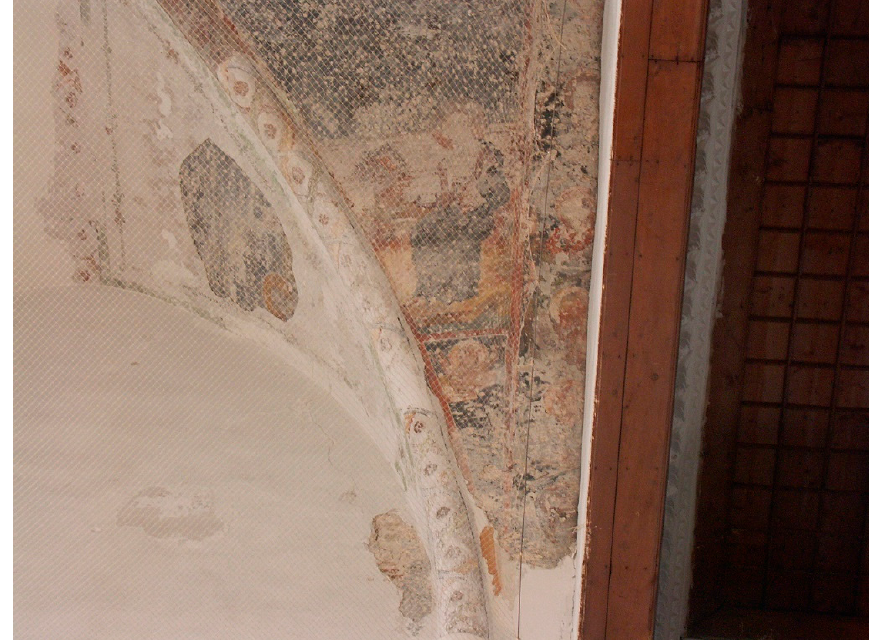
Figure 5. Pera, the church of St. Paul, the vault of the choir, St. Mark (mid-14th century?), fot. R. Quirini-Popławski (2007). Arts 2019 , 8 , x FOR PEER REVIEW